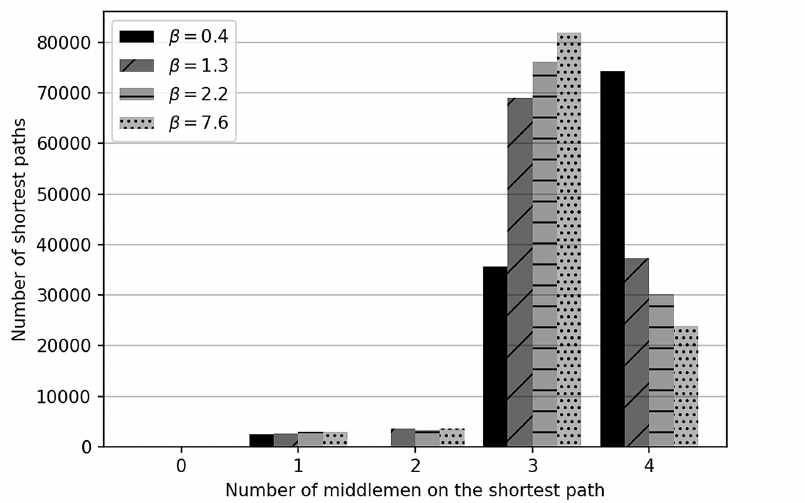
Figure 2. Number of shortest paths by the number of their middlemen.